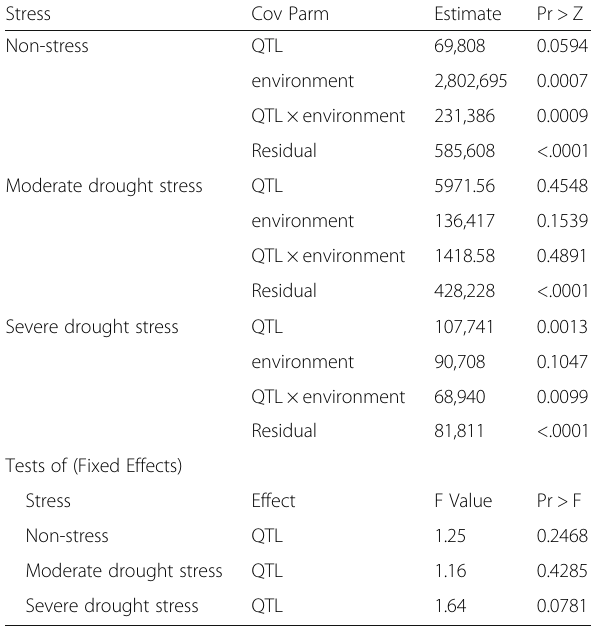
Table 1 The mixed model (REML) parameters of the combined analysis for all three stresses levels